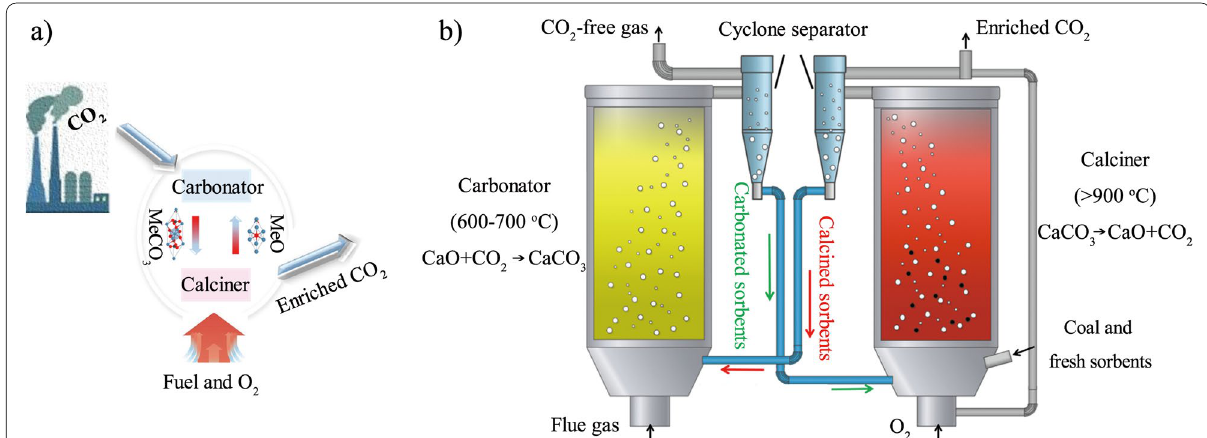
Fig. 4 Schematic representation of the calcium-looping process suitable for CO 2 capture from post-combustion flue gas ( a ), and gas-solid fluidized beds ( b